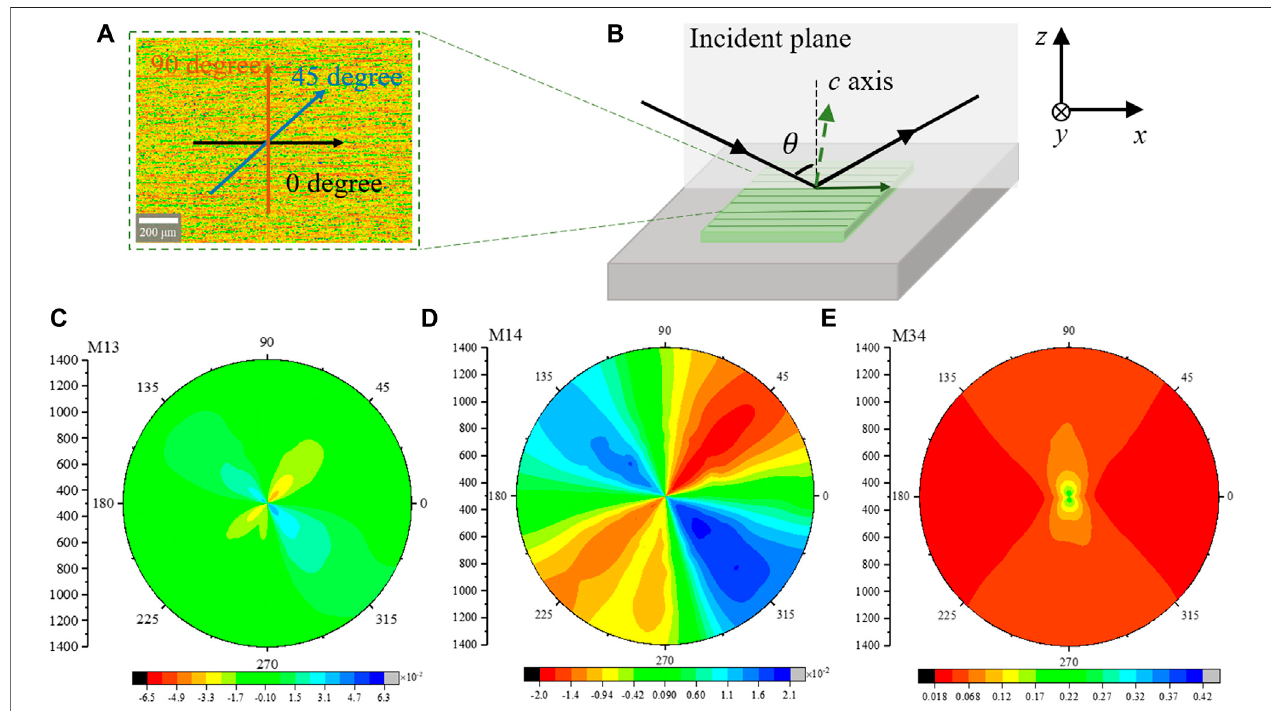
FIGURE 5 | (A) The surface morphology of the rough grinding wafer and its initial texture direction parallel to the plane of incidence where the direction of rotation angle is anticlockwise. (B) The schematic diagram of re fl ection ellipsometry measurement. (C – E) are the experimental MMSE data of individual M13, M14, and M34 elementsfrom0to360 ° rotationanglesin65 ° incidentangle,respectively.MMintensitiesareplottedinpolarcoordinateswithwavelengthandrotationangleasradialand angular